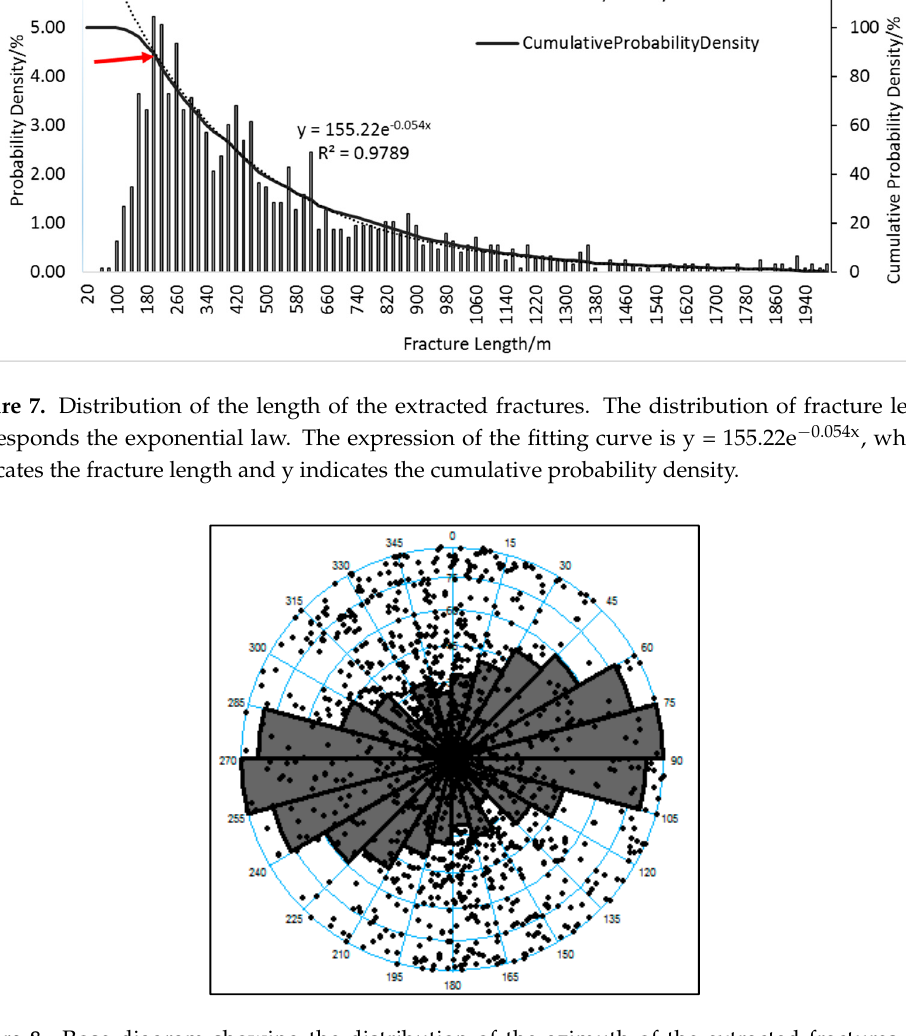
Figure 8. Rose diagram showing the distribution of the azimuth of the extracted fractures from seismic activity.